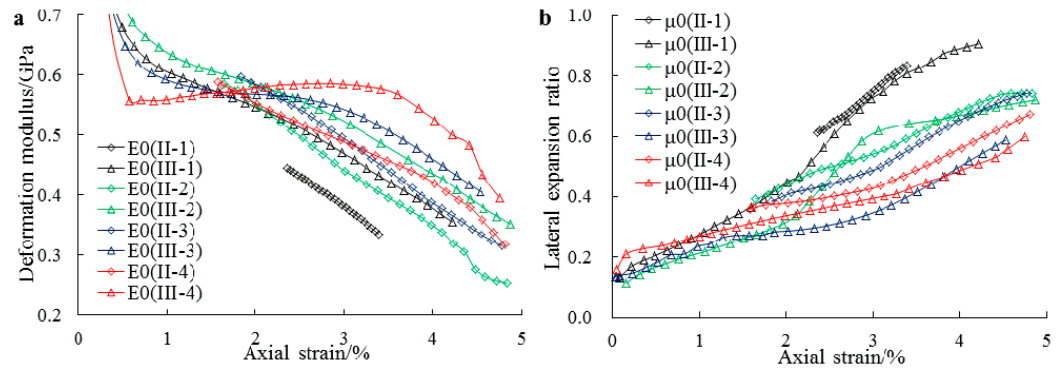
Figure 11. Change of deformation modulus ( a ) and lateral expansion ratio ( b ) with the axial strain.